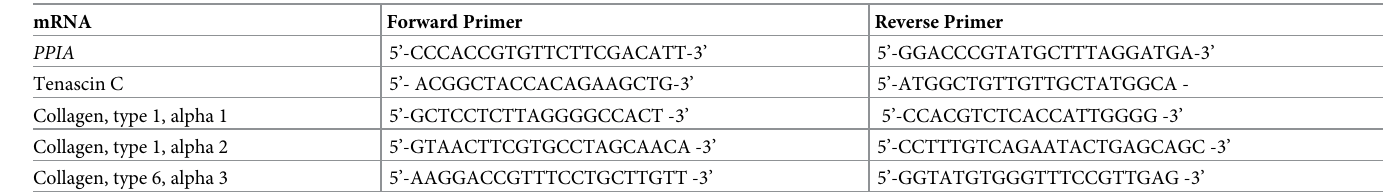
Table 1. List of primer sequences used for quantitative